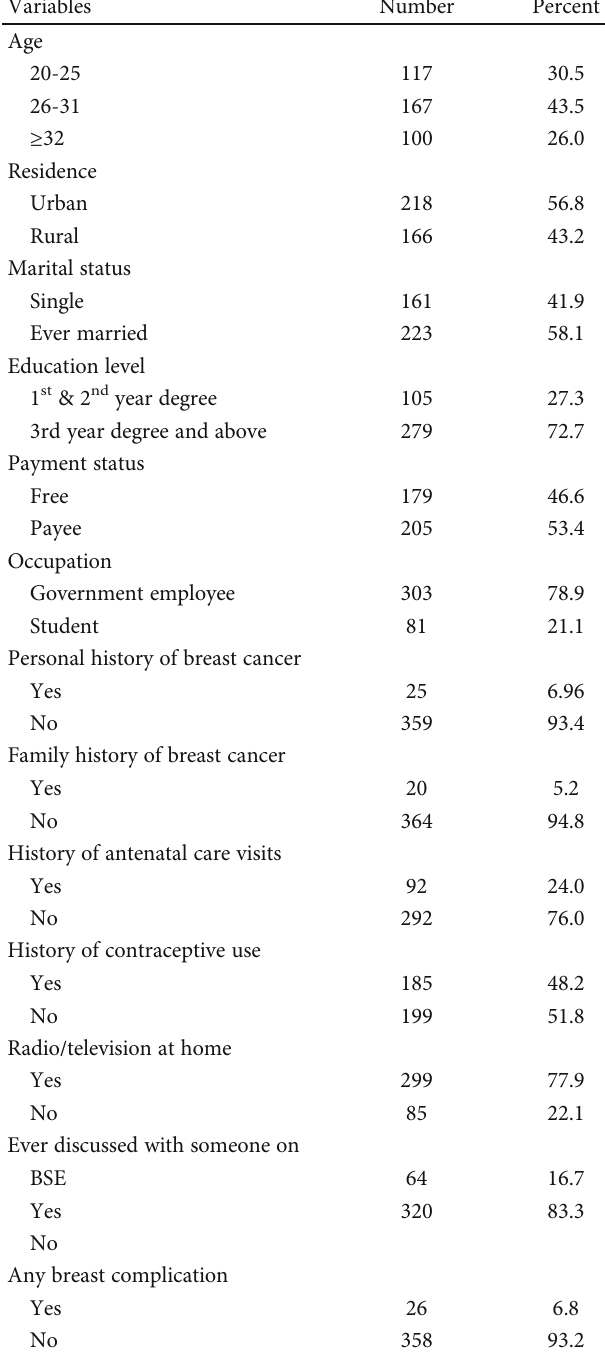
Table 1: Sociodemographic and general characteristics of summer social science female students in University of Gondar, Northwest Ethiopia, 2018 ( n = 384